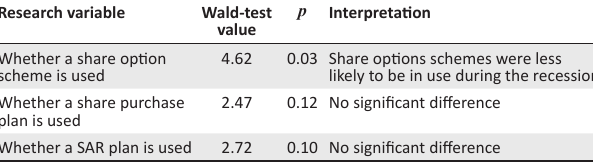
TABLE 5: Differences between the pre- and during-recession